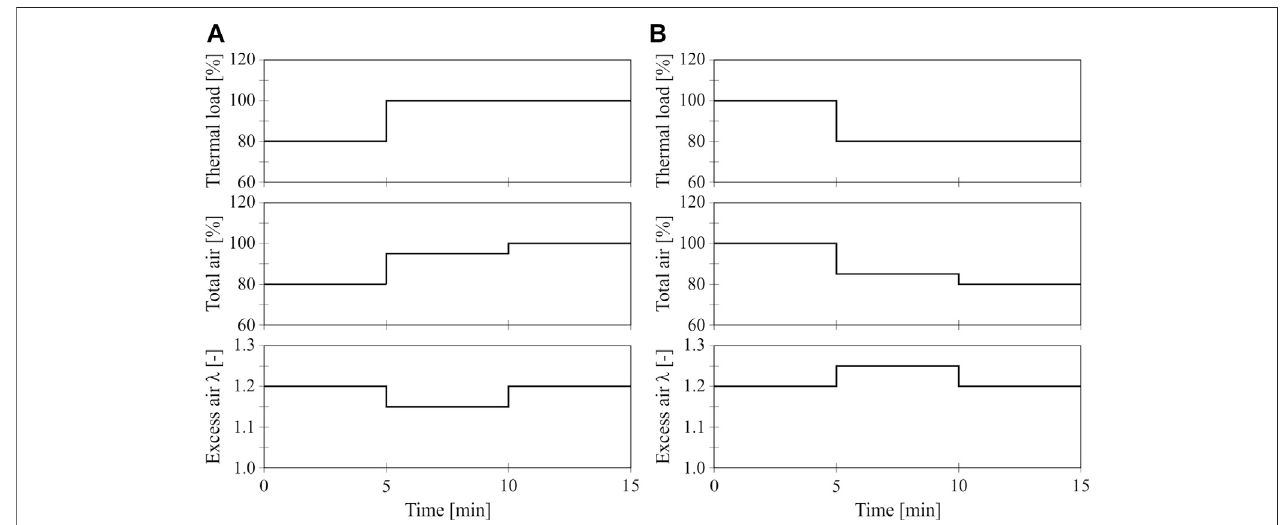
FIGURE 14 | Utilization of the excess air factor effect. (A) Load increase (B) Load